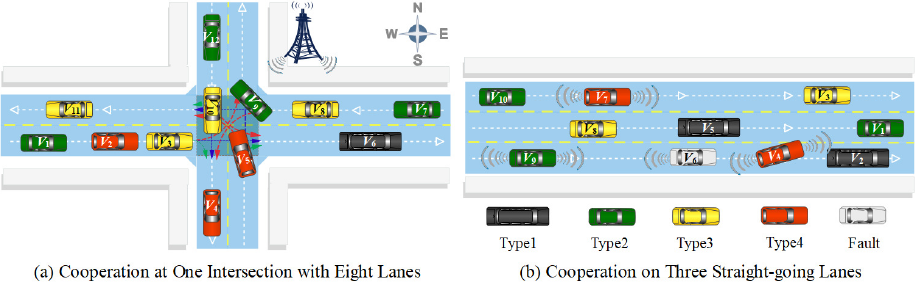
Figure 1. Typical V2X-based Cooperative Situations of Intelligent Vehicles. ( a ) Cooperation at One Intersection with Eight Lanes. ( b ) Cooperation on Three Straight-going